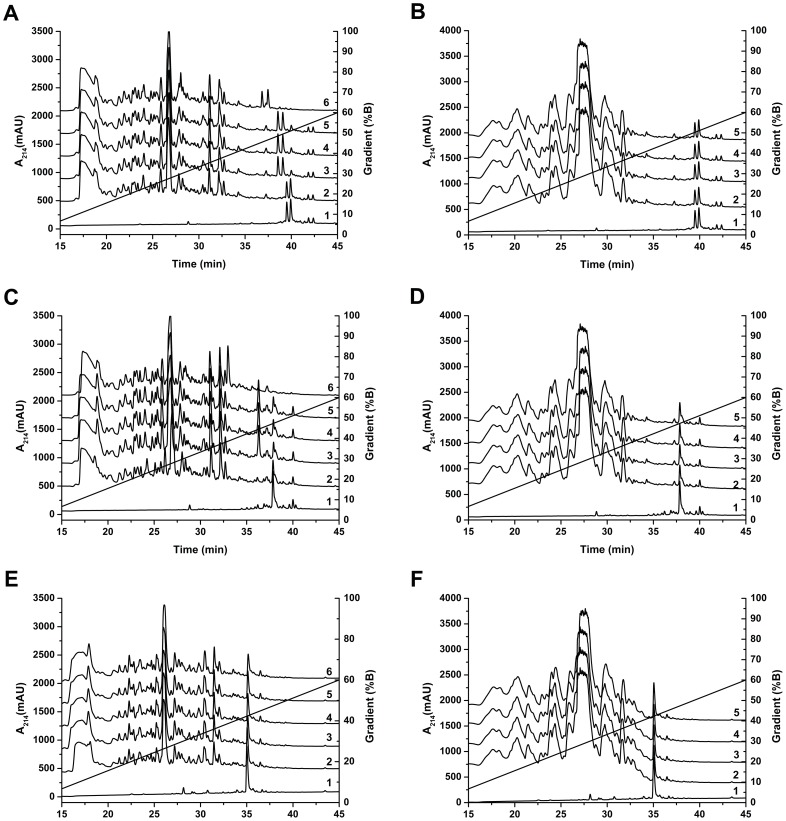
HPLC chromatograms of bCAT, hCAT and CTL alone or with different bacterial strain supernatants, with or without protease inhibitors.(A): Alignment of the HPLC chromatograms corresponding to: (1) bCAT, (2) bCAT+MHB, (3) bCAT+S49775, (4) bCAT+S25923 (5) bCAT+S1 (6) bCAT+S2. (B): Alignment of the HPLC chromatograms corresponding to: (1) bCAT, (2) bCAT+Pi+S49775, (3) bCAT+Pi+S25923 (4) bCAT+Pi+S1 (5) bCAT+Pi+S2. (C): Alignment of the HPLC chromatograms corresponding to: (1) hCAT, (2) hCAT+MHB, (3) hCAT+S49775, (4) hCAT+S25923 (5) hCAT+S1 (6) hCAT+S2. (D): Alignment of the HPLC chromatograms corresponding to: (1) hCAT, (2) hCAT+Pi+S49775, (3) hCAT+Pi+S25923 (4) hCAT+Pi+S1 (5) hCAT+Pi+S2. (E): Alignment of the HPLC chromatograms corresponding to: (1) bCTL, (2) bCTL+MHB, (3) bCTL+S49775, (4) bCTL+S25923 (5) bCTL+S1 (6) bCTL+S2. (F): Alignment of the HPLC chromatograms corresponding to: (1) bCTL, (2) bCTL+Pi+S49775, (3) bCTL+Pi+S25923 (4) bCTL+Pi+S1 (5) bCTL+Pi+S2.